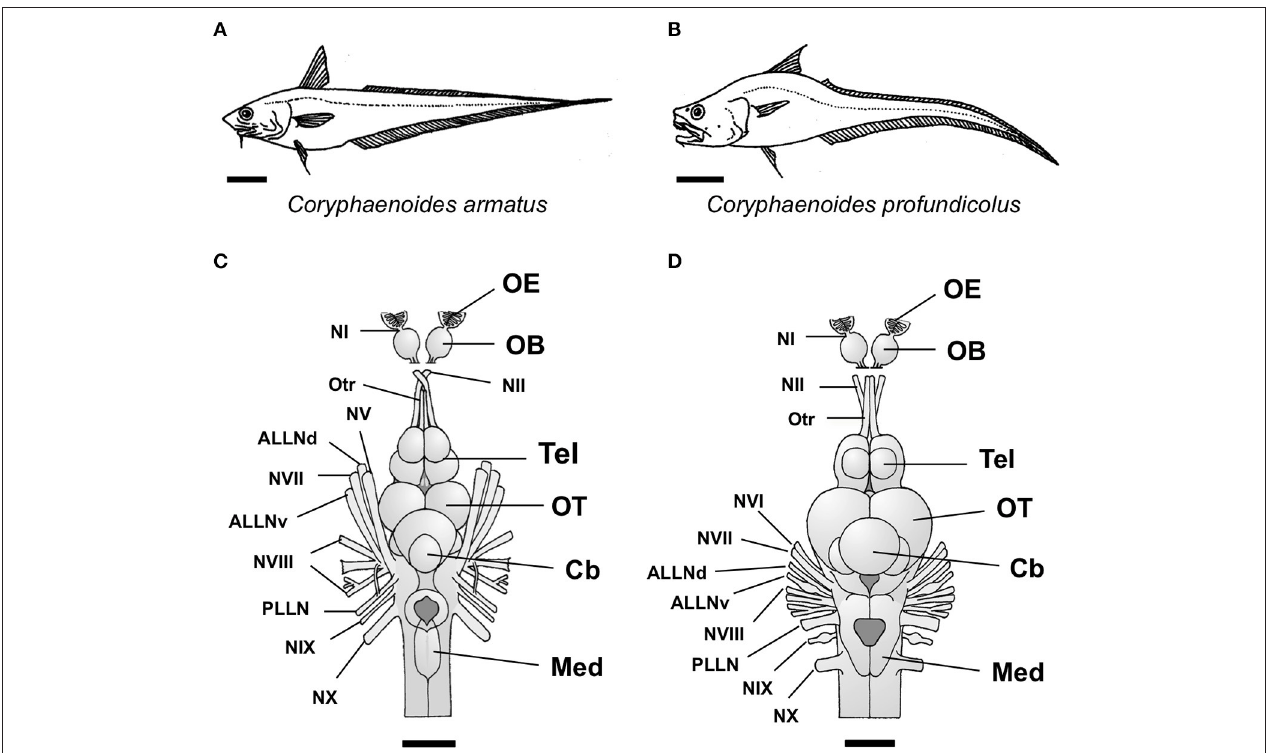
FIGURE 1 | The two species of deep-sea grenadier investigated in this study, the abyssal grenadier Coryphaenoides armatus (A) and the deep-sea grenadier C. profundicolus (B) . Dorsal views of the brain and the cranial and sensory nerves from the two largest individuals of these species investigated are presented in (C) C. armatus (900mm SL) and (D) C. profundicolus (890mm SL). In both species, the olfactory bulbs (OB) are stalked. The olfactory epithelium (OE) is positioned very close to the olfactory bulbs and the olfactory nerve (NI) is very short. The olfactory bulbs are connected to the telencephalon (Tel) by long olfactory tracts (Otr). ALLNd, dorsal root of the anterior lateral line nerve; ALLNv, ventral root of the anterior lateral line nerve; Cb, cerebellum; Med, medulla; NI, olfactory nerve (cranial nerve I); NII, optic nerve (cranial nerve II); NV, cranial nerve V; NVI, cranial nerve VI; NVII, cranial nerve VII; NVIII, cranial nerve VIII; NIX, cranial nerve IX; NX, cranial nerve X; OB, olfactory bulbs; OE, olfactory epithelium; OT, optic tectum; Otr, olfactory tract; PLLN, posterior lateral line nerve; Tel, telencephalon. Scale bars: 10cm (A) ; 10cm (B) ; 3cm (C) ; 2.5cm (D)